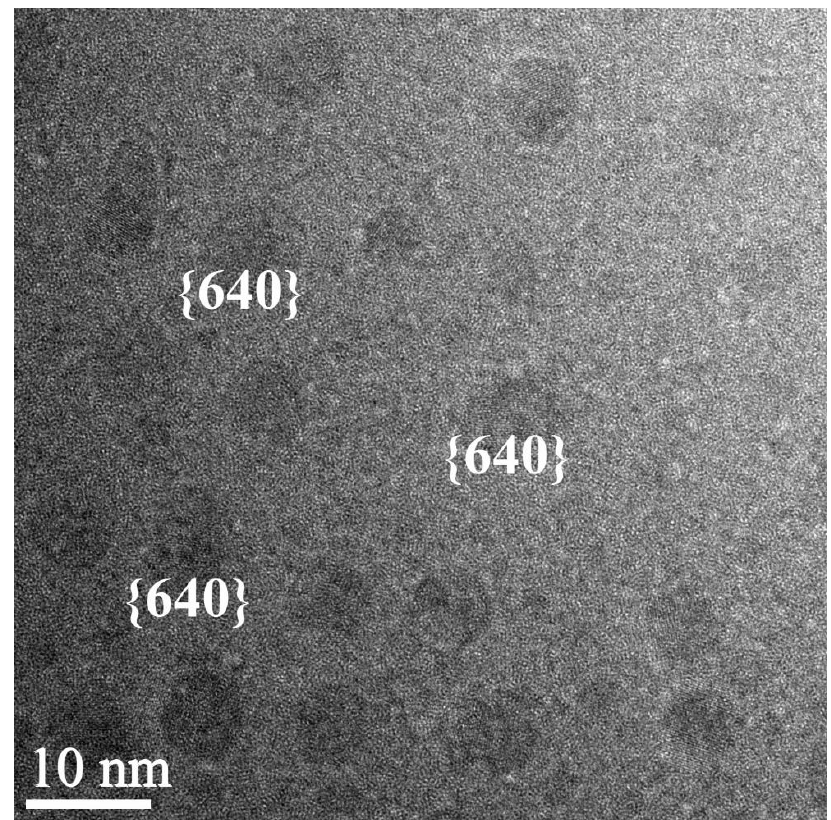
Figure 3. Cross section high resolution transmission electron microscopy (HRTEM) image of molecular beam epitaxy (MBE) MnGe layer deposited at 350